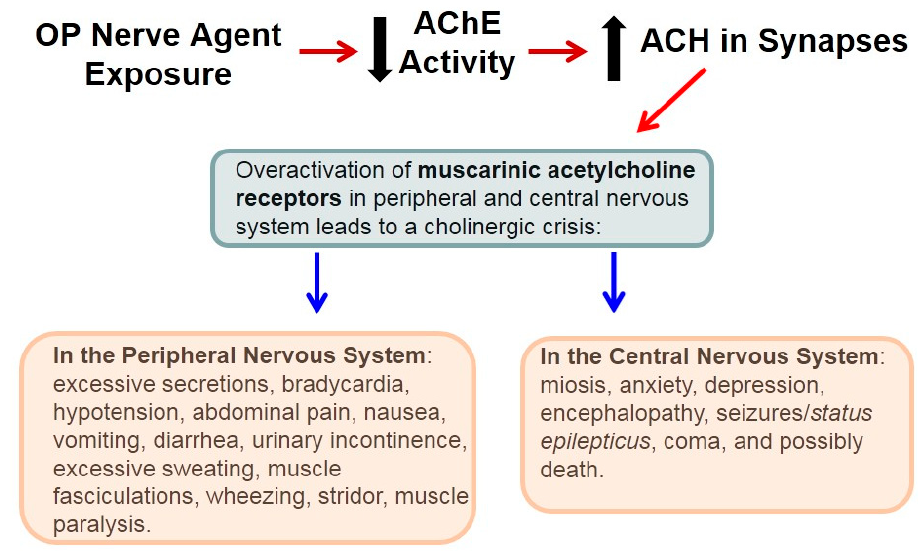
Figure 1. Signs and symptoms after acute intoxication to an OP nerve agent. Exposure to a the chemical warfare agent such as soman results in the inhibition of acetylcholinesterase (AChE) activity leading to excessive accumulation of acetylcholine (ACH) within synapses. These physiological alterations result in the overactivation of muscarinic receptors and a cholinergic crisis in the peripheral and central nervous system.